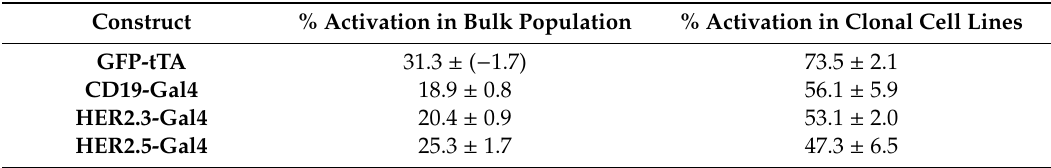
Table 2. Quantification of activation of synNotch receptor systems in bulk populations and clonal cell lines after 60 min of antigen contact and a ratio of one sender cell to one receiver